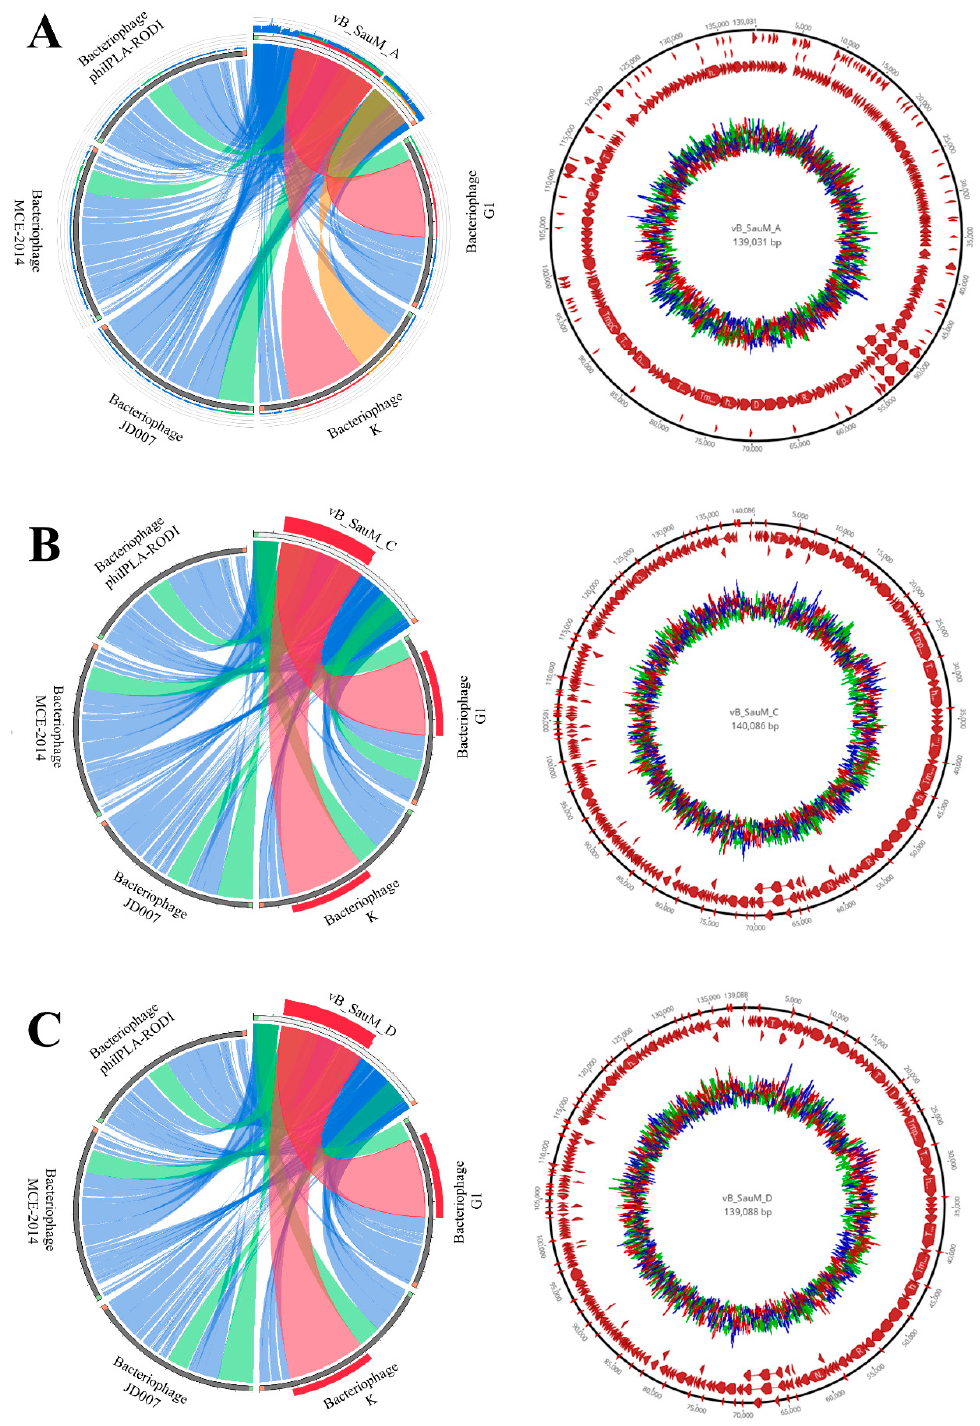
Figure 4. Genome organization of isolated bacteriophages. Comparison of genomes of isolated bacteriophages with selected kayviruses, where: blue represents more than 50% similarity, green more than 75% similarity, orange more than 90% similarity and the red represents more than 99% similarity. ( A ) genome similarity of bacteriophage vB_SauM-A with other kayviruses and genome organization and G + C screw of vB_SauM-A genome. ( B ) Genome similarity of bacteriophage vB_SauM-C with other kayviruses and genome organization and GC screw of vB_SauM-C genome. ( C ) genome similarity of bacteriophage vB_SauM-D with other kayviruses and genome organization and GC screw of vB_SauM-D